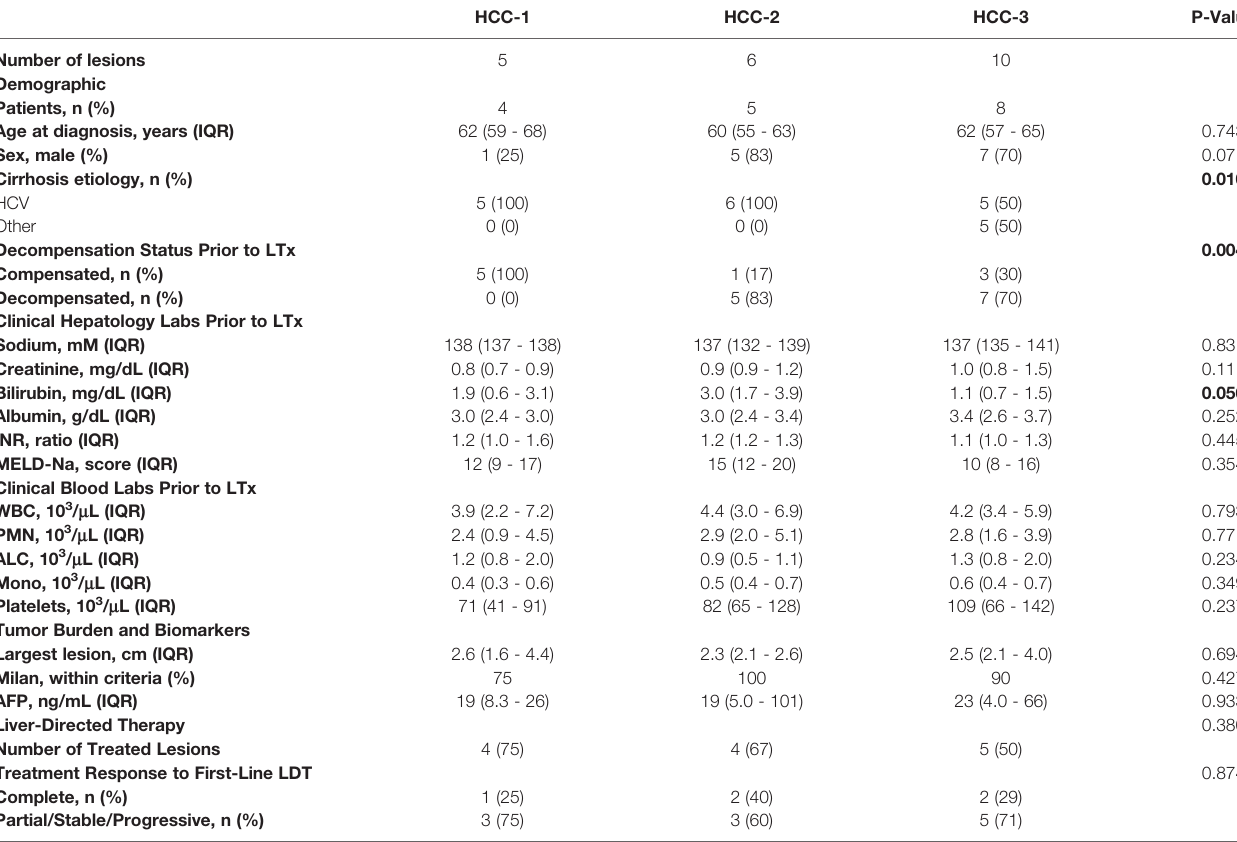
TABLE 5 | Pre-transplant clinical variables by HCC subtype.